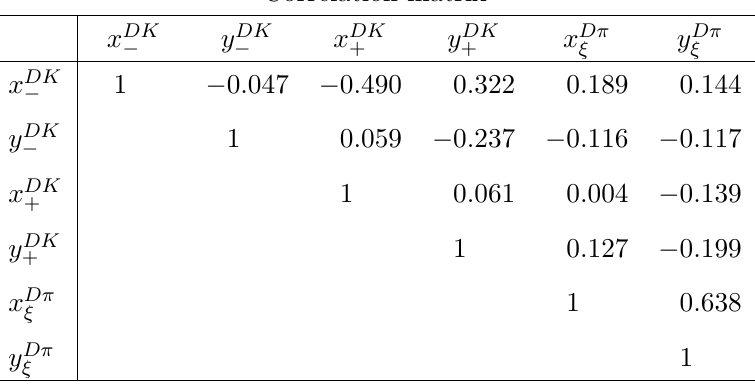
Table 5 . Systematic uncertainties, σ , for x DK the corresponding correlation